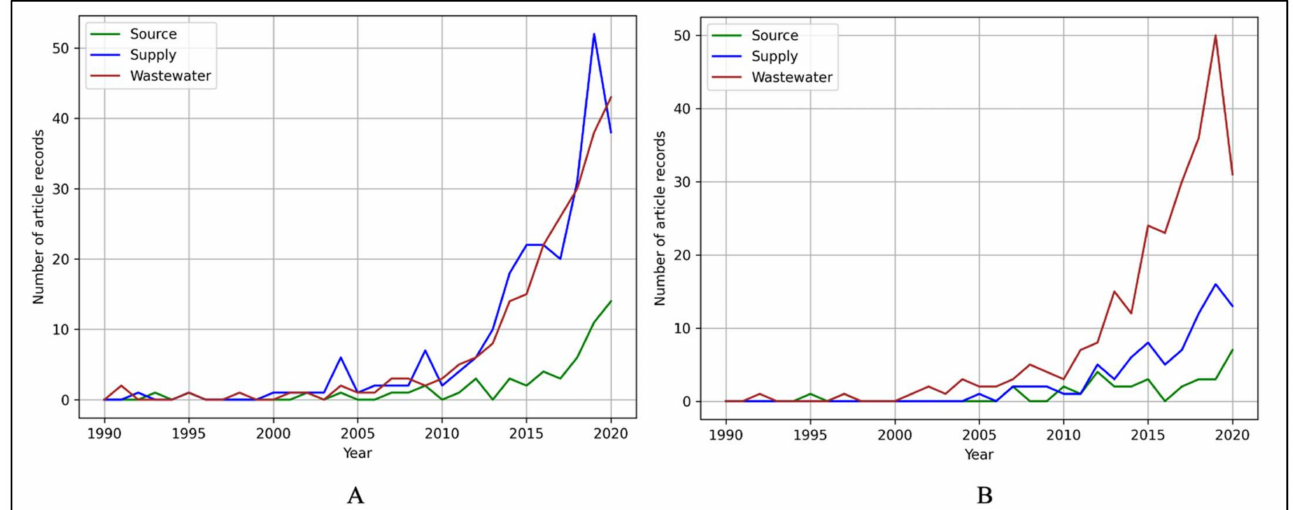
Figure 8. ( A ) Trends of the article records from 1990–2020 by water type classification for primary thematic focus ( n = 534). ( B ) Trends of the article records from 1990–2020 by water type classification for secondary thematic focus ( n =